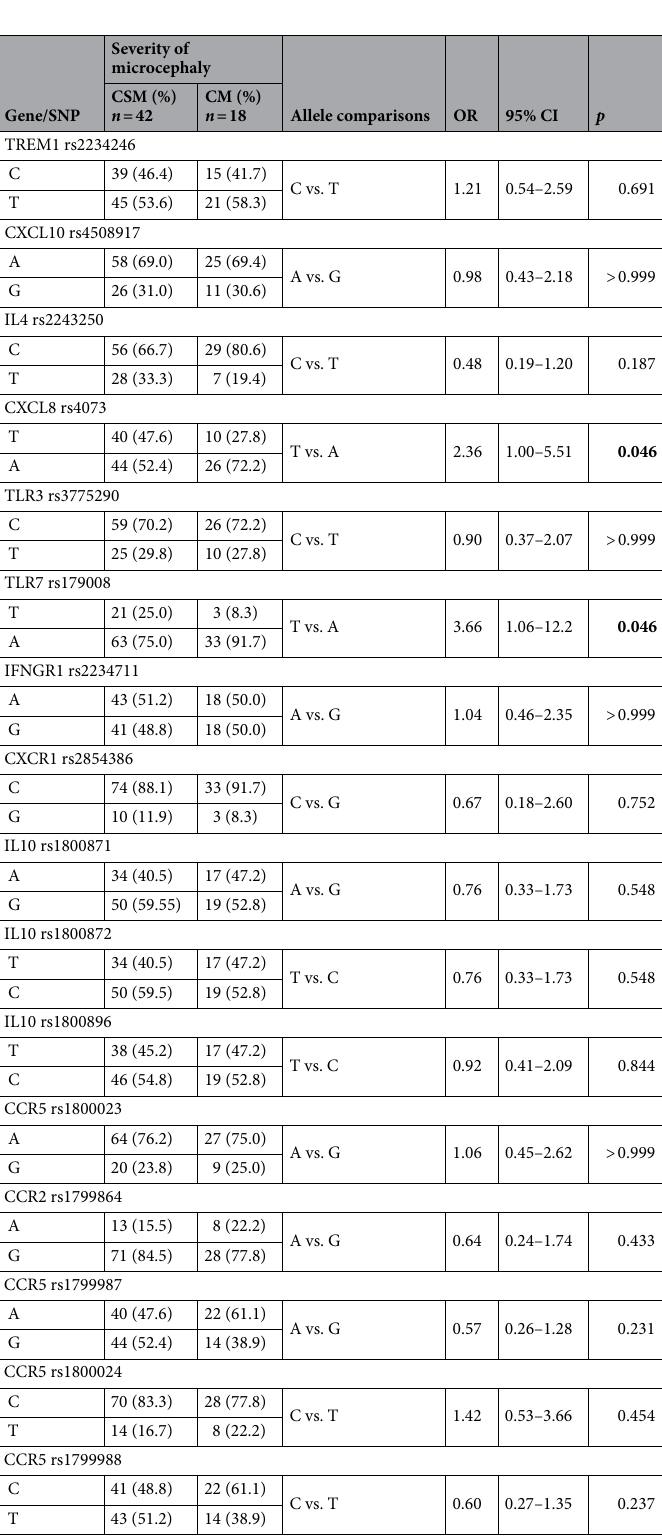
Table 5. Association between CXCL8 rs4073 and TRL7 rs179008 allele frequencies with microcephaly severity. (%) number of subjects with the specified allele. CSM, children with severe microcephaly